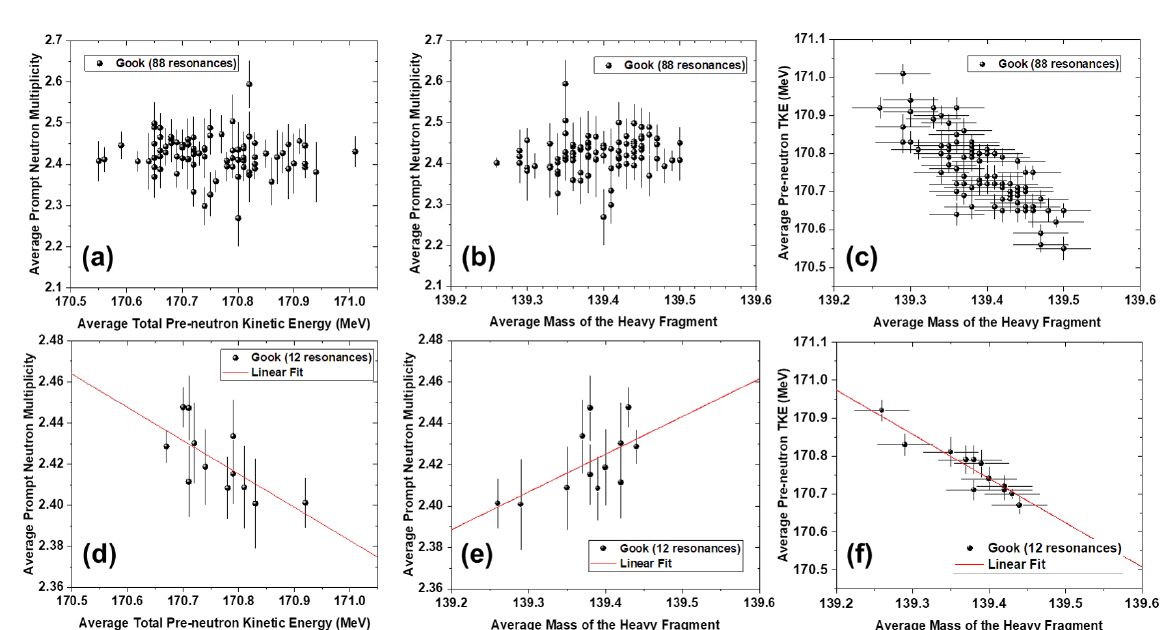
Figure 1. Relative average prompt neutron multiplicity from 1 eV to 100 eV for the 235 U(n,f) reaction. Data from Howe [12] are relative to the average ν P -value over incident neutron energies from 0.52 to 114 eV. Data from Simon [13] and Reed [14] were renormalized to the thermal ν P -value and data from Frehaut [15] were renormalized to ν P -value from 252 Cf(sf). Figure 2. Correlations measured by JRC-Geel [6, 7, 9] between ν P and TKE (Fig. (a)), between ν P and A H (Fig. (b)) and between TKE and A H (Fig. (c)) for the 88 resonances. The same correlations are plotted in Figs. (d), (e) and (f), but for the 12 most accurate resonances. Red lines correspond to a linear fit performed over experimental points. Note the large di ff erences in scale between subfigures (a), (b) and (c),